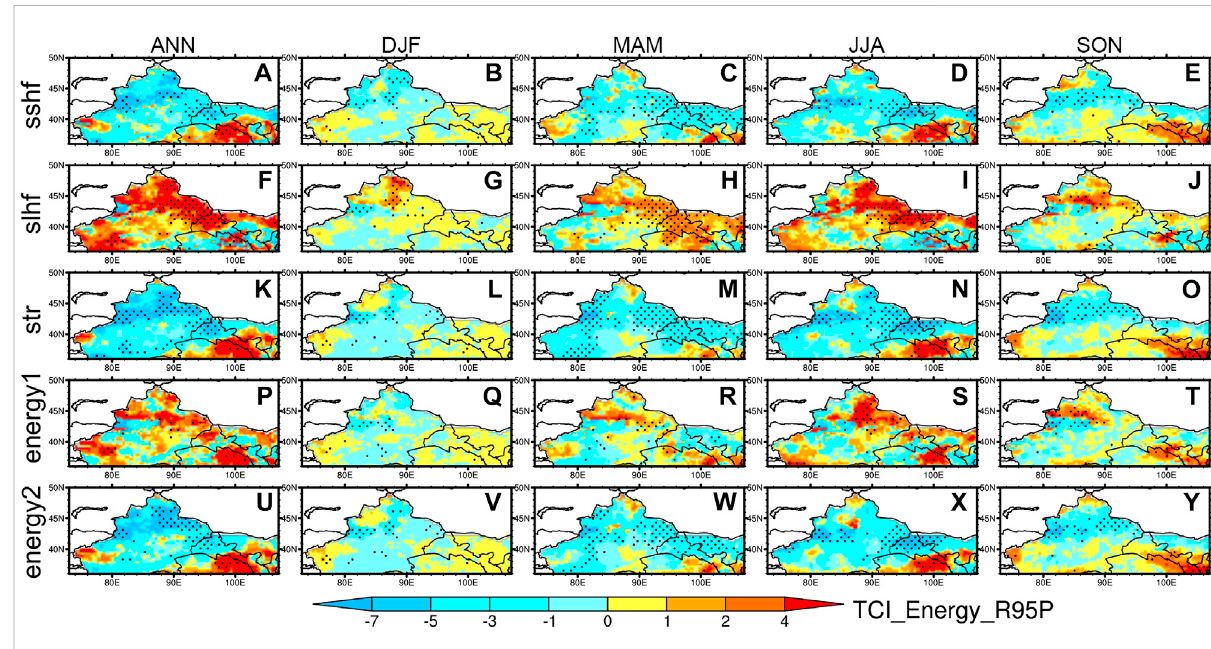
FIGURE 10 Spatial distributions of the annual and seasonal coupling index of sshf, slhf, str, energy1, and energy2 with R95P. The rest of the caption is the same as in Figure 6.